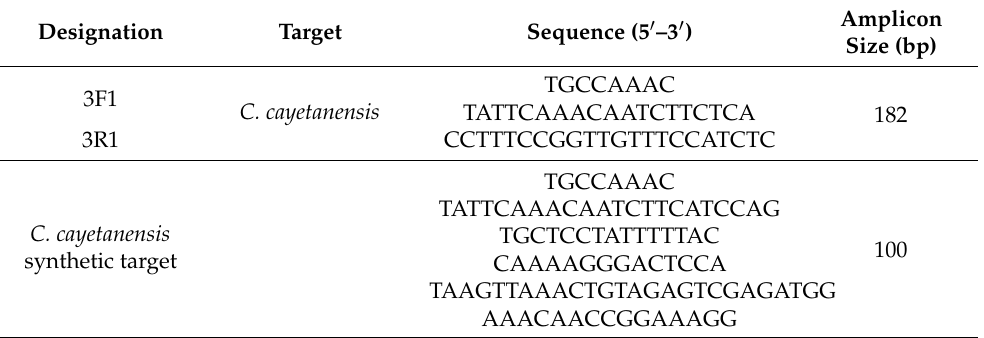
Figure 1. Allelic hotspots and gene annotations of C. cayetanensis mitochondrial genome. Annotations of KP231180, the reference mitochondrial genome of C. cayetanensis [31], are illustrated. Two coding sequences CDS cox1 and cox3 (blue) contain a few polymorphic alleles, but the majority of the allelic hotspots (base-positions marked in red) are distributed across the genome, including among rRNA genes (green) and intergenic regions. The hotspots were identified by manually curating multiple alignments of genomes with the reference genome KP231180 [34,36]. The rRNA-containing segment between 3900 and 4100 with two SNPs was targeted by the mit3PCR developed in this study (green triangles). Table 1. Sequences of PCR primers and positive control used in this